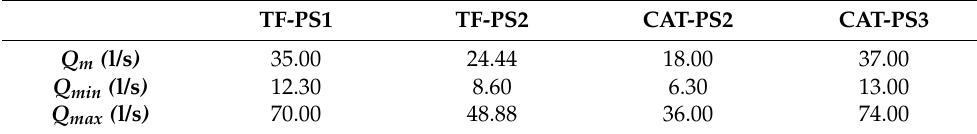
Table 4. Demand flows for the different